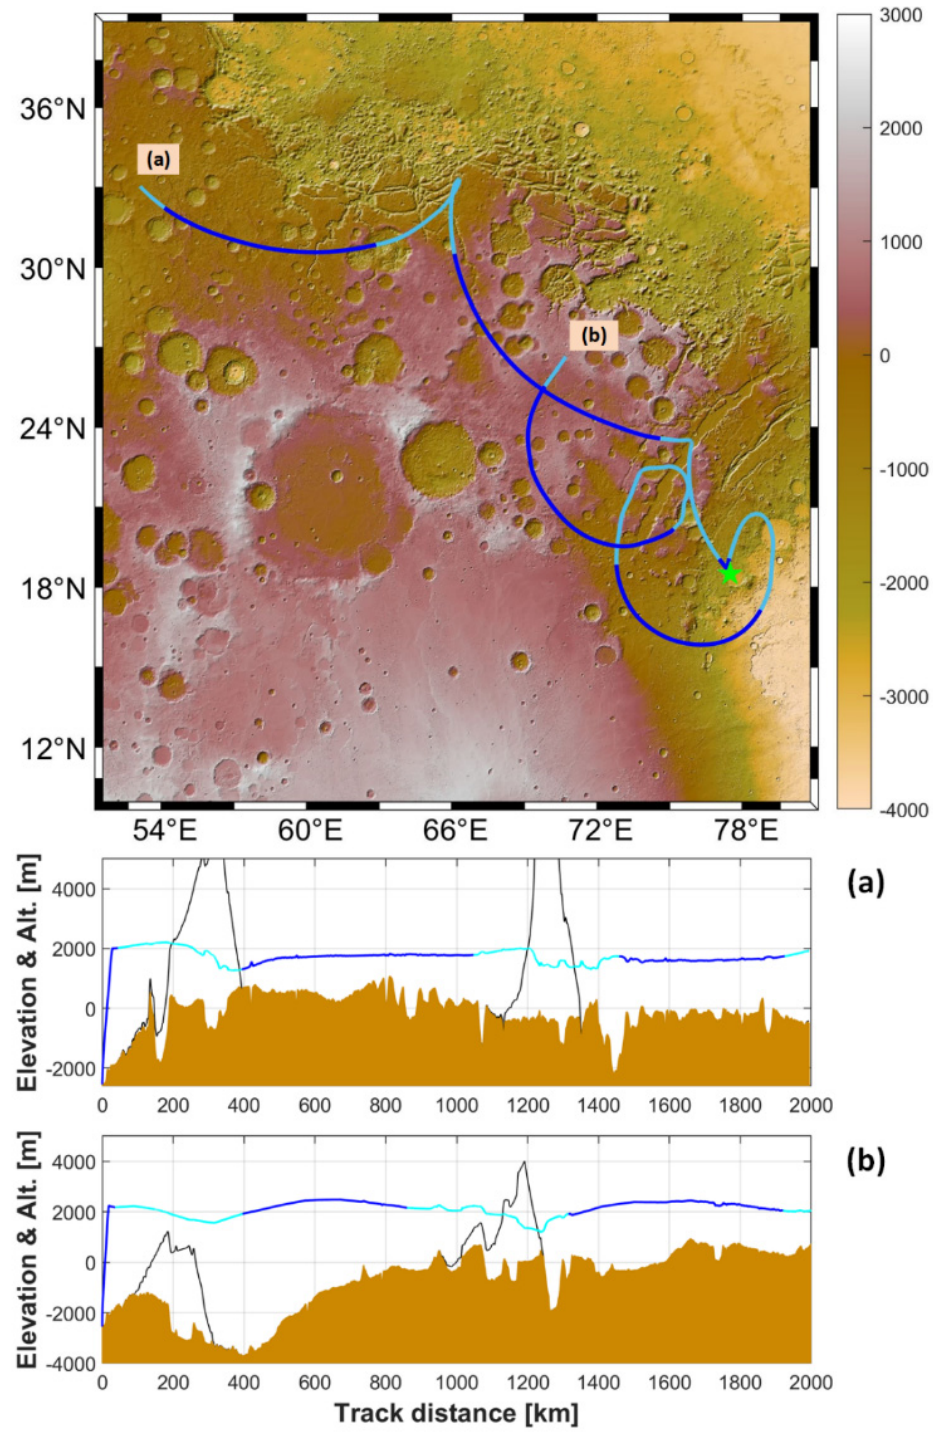
Figure 3. Trajectory simulations for flights during northern summer season (( a ), Ls = 60 ◦ ) and northern winter season (( b ), Ls = 240 ◦ ) for a flight time of 50 h. Balloon launch site in Jezero crater is marked with a green star. Daytime flight segments are colored in light blue and nighttime segment in dark blue, respectively. The altitude/elevation chart displays likewise the flight trajectory in day/night segments. The daytime convective layer vertical extend is indicated in black. This chart is created by using the mapping toolbox from [36].